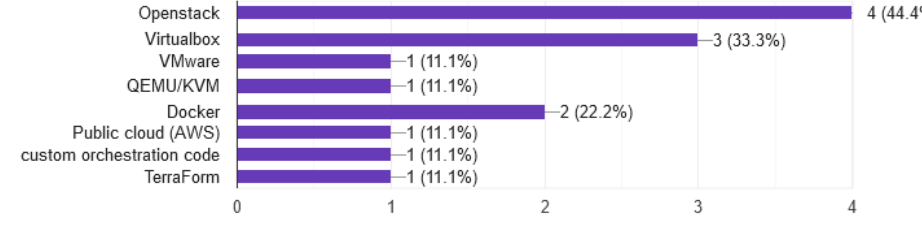
Figure 7. Infrastructure